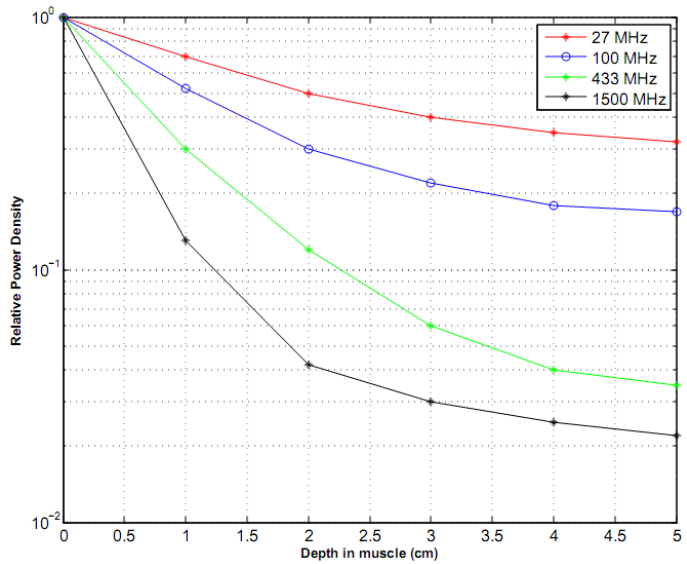
Figure 1. Power absorption in muscle as a function of depth at different frequencies.